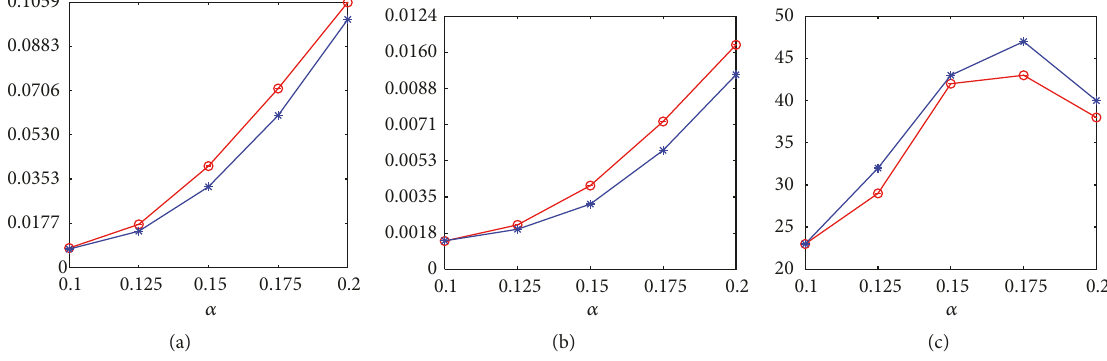
Figure 10: Comparison of three quantities of rumor propagation before and after deleting 7 nodes in Email-URV: (a) the average propagation size, (b) the averagepeak prevalence,and (c) the arrival time of the averagepeak prevalence(red circles representthe situation before deleting and blue stars represent the situation after deleting).